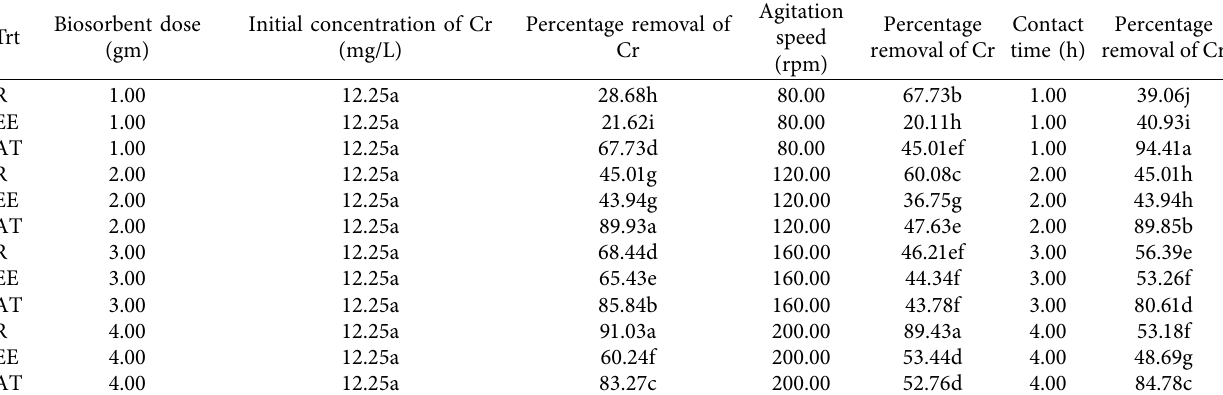
Table 3: Te efect of biosorbent dose, contact time, and agitation speed on chromium removal from tannery wastewater efuents. Biosorbent dose Trt (gm)